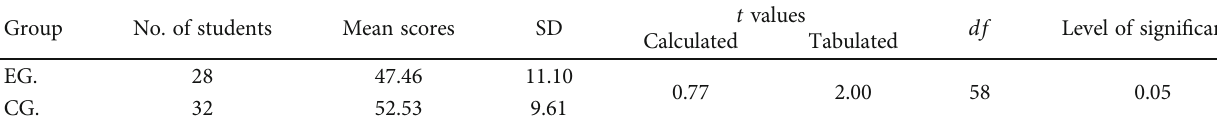
Table 3: The mean scores, standard deviations, and t values of the two groups on the pretest. Group No. of students EG.